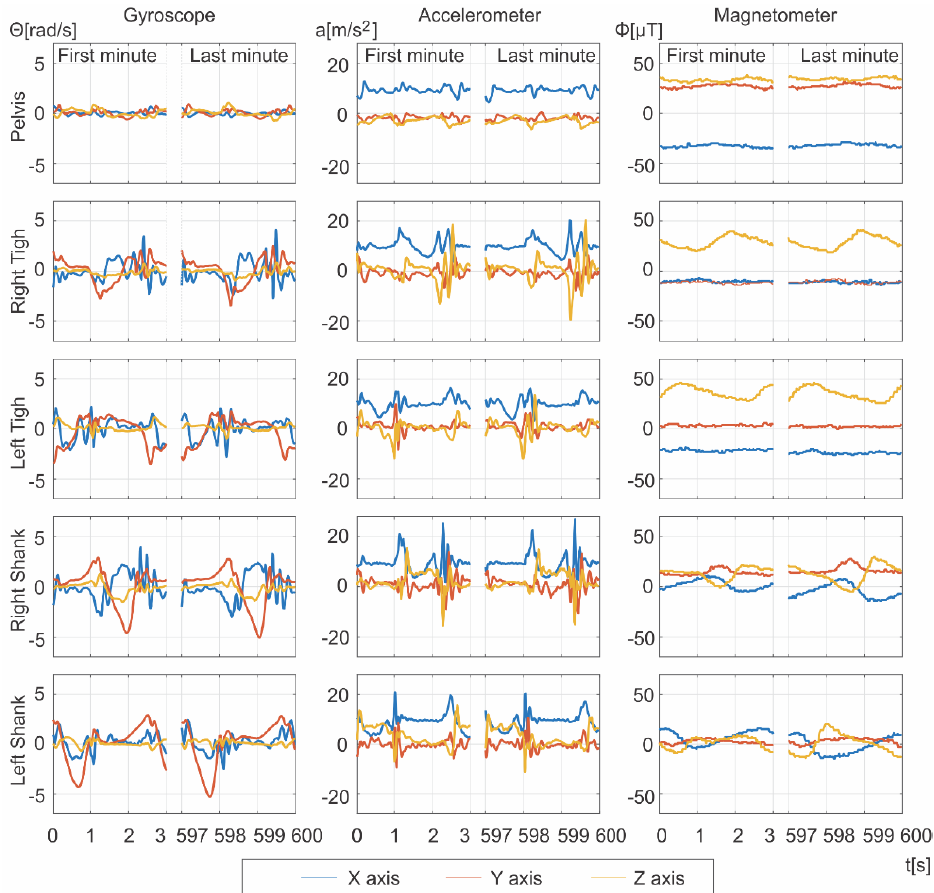
Figure 8. First column shows the gyroscope signals from the IMUs attached to the pelvis, right/left thigh, and right/left lower leg. Second column shows the accelerometer signals, and third column shows the magnetometer signals for the IMUs attached to the pelvis, right/left thigh and right/left lower leg. The subject walked on the treadmill for 10 min. Left side of each graph shows the curves for the first minute of walking, and right side of each graph shows the curves for the last minute of walking. Blue, orange, and yellow curves represent the x -axis, y -axis, and z -axis signals, respectively.